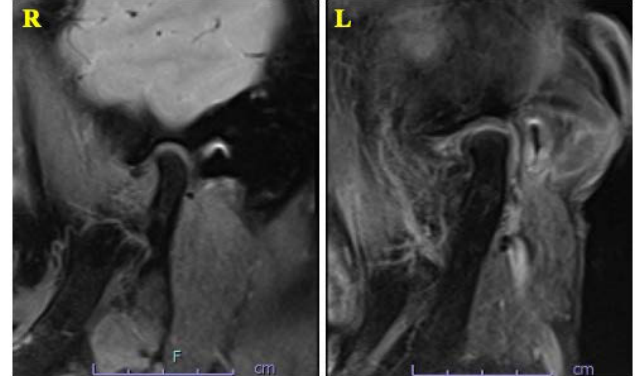
Figure 3. MRI T2-weighted imaging showing irreducible anterior disc displacement of bilateral ar- ticular disks and joint effusion in the joint capsule on the left side.